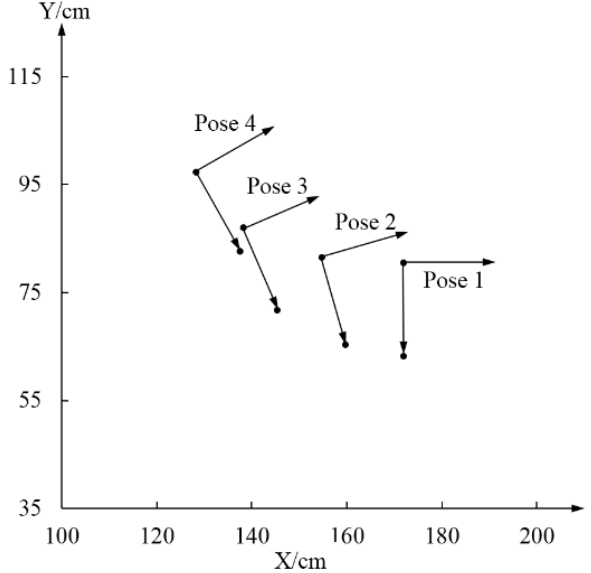
Figure 9. Four task poses. Table 1. The specific values of four task poses.